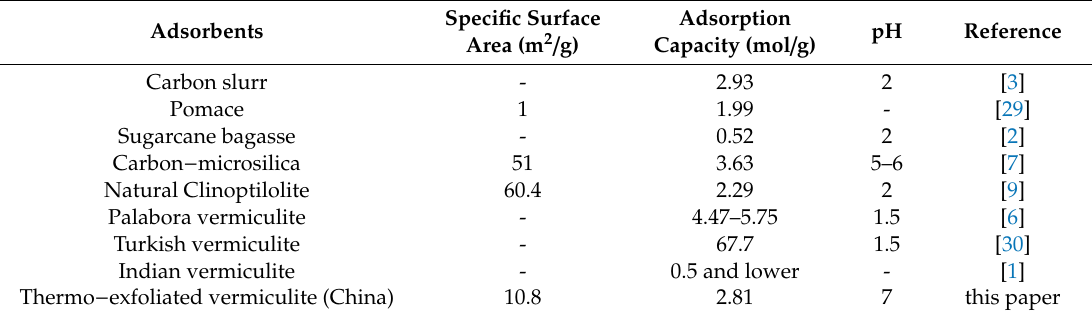
Table 8. Comparison of adsorption capacity of Chinese vermiculite thermoexfoliated for Cr 6 + with that of di ff erent adsorbents. Note: Adsorption capacity values have been recalculated for an initial Cr 6 + concentration of 1